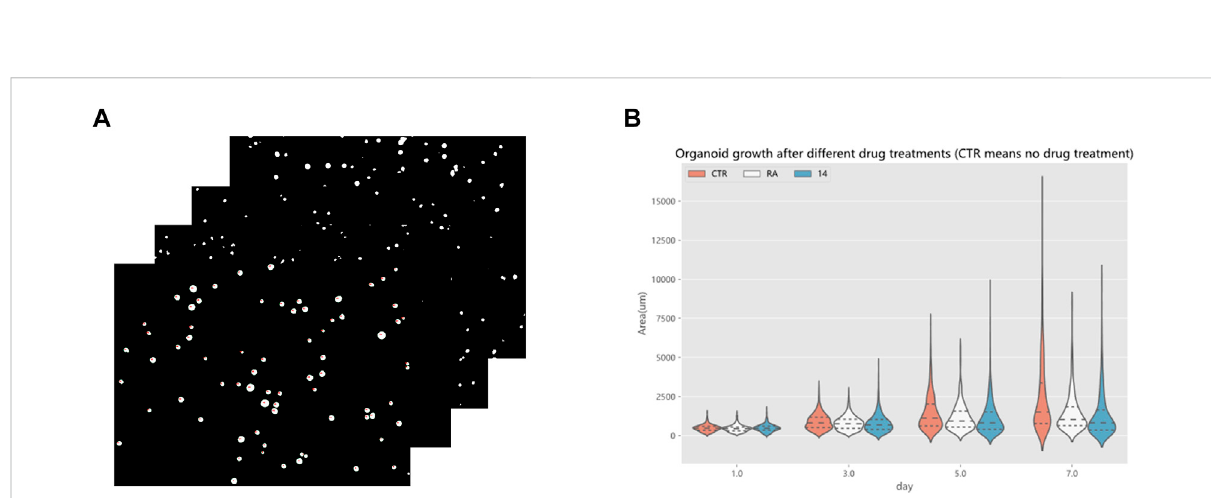
FIGURE 14 Drug screening evaluation by the RDAU-Net model. (A) Area statistics of the organoid in the images (only a small part is shown here). (B) Violin plot shows the area changes of organoids in CTR, RA, and 14 groups at days 1, 3, 5 and 7. The area data statistics of the organoids of different treatments on the same day can clearly show the difference between the size of the organoids (adding a quartile distribution map, the dotted line in the middle indicates the median of the data in this